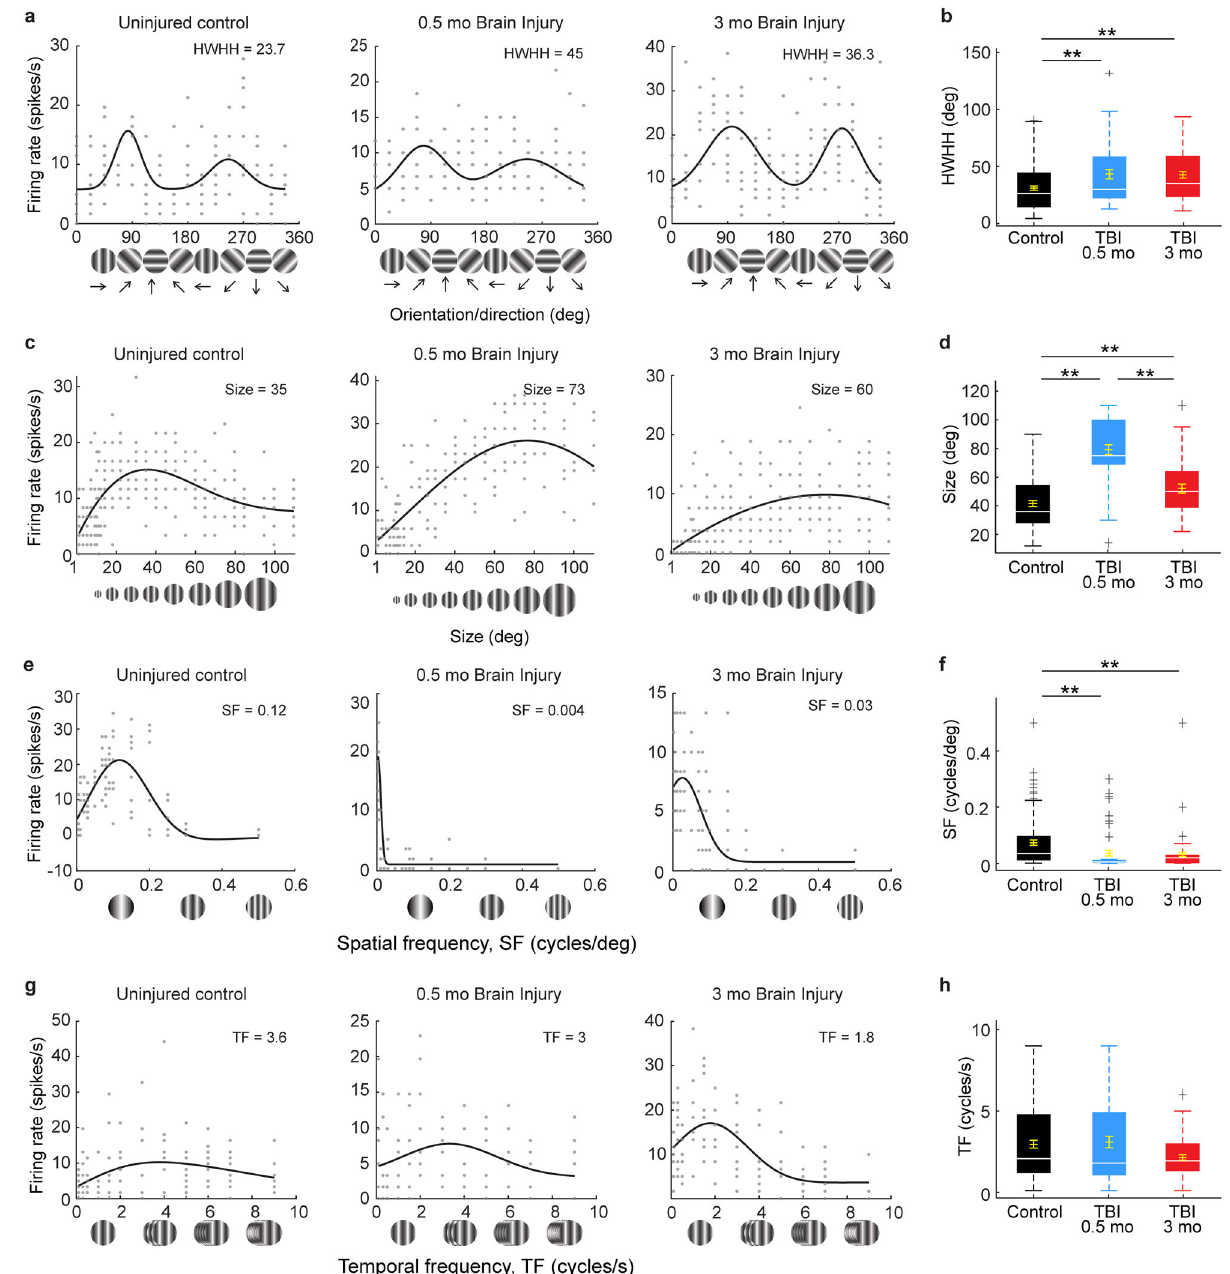
Fig. 7 TBI disrupts V1 neuron tuning curves in response to drifting gratings. a, b Orientation tuning curves for single neurons in an uninjured control (black) and CCI-injured mice 0.5 months (blue) and 3 months (red) after injury. To facilitate comparisons across examples orientation preferences have been aligned to 90° and 270°, with 90° representing the preferred direction. Tuning values are given as the half-width at half-height (HWHH) in degrees in each panel ( a ) and the population averages are quanti fi ed in ( b ). * *P = 0.03, control versus 0.5 months after TBI, ** P = 1.99E-03, control versus 3 months after TBI; Kruskal – Wallis H with Dunn ’ s post hoc. n = 109 cells from 7 uninjured controls, 54 cells from 5 mice 0.5 months after TBI, and 75 cells from 5 mice 3 months after TBI. c , d Single neuron examples and population average quanti fi cation of aperture size (in degrees). ** P = 9.56E-10, control versus 0.5 months after TBI, * P = 0.042, control versus 3 months after TBI, ** P = 2.04E-05, 0.5 versus 3 months after TBI; Kruskal – Wallis H with Dunn ’ s post hoc. n = 81 cells for control, 45 cells 0.5 months after TBI and 41 cells 3 months after TBI. e , f Single neuron examples and quanti fi cation of spatial frequency (SF). ** P = 3.80E-06, control versus 0.5 months after TBI, ** P = 6.51E-03, control versus 3 months after TBI, Kruskal – Wallis H with Dunn ’ s post hoc. n = 105 cells for control, 55 cells 0.5 months after TBI, 71 cells 3 months after TBI. g , h Single neuron examples and quanti fi cation of temporal frequency (TF). P = 0.26; Kruskal – Wallis H test. Optimal values for each parameter are given in each panel. n = 95 cells for control, 59 cells 0.5 months after TBI, and 70 cells 3 months after TBI. Background activity for each cell is indicated by gray dashed lines. For box plots, dashed error bars represent the maximum and minimum observations within 1.5 inter-quartile range of the 25th and 75th percentile; values greater than 1.5 inter-quartile range of the 75th percentile are indicated by + .